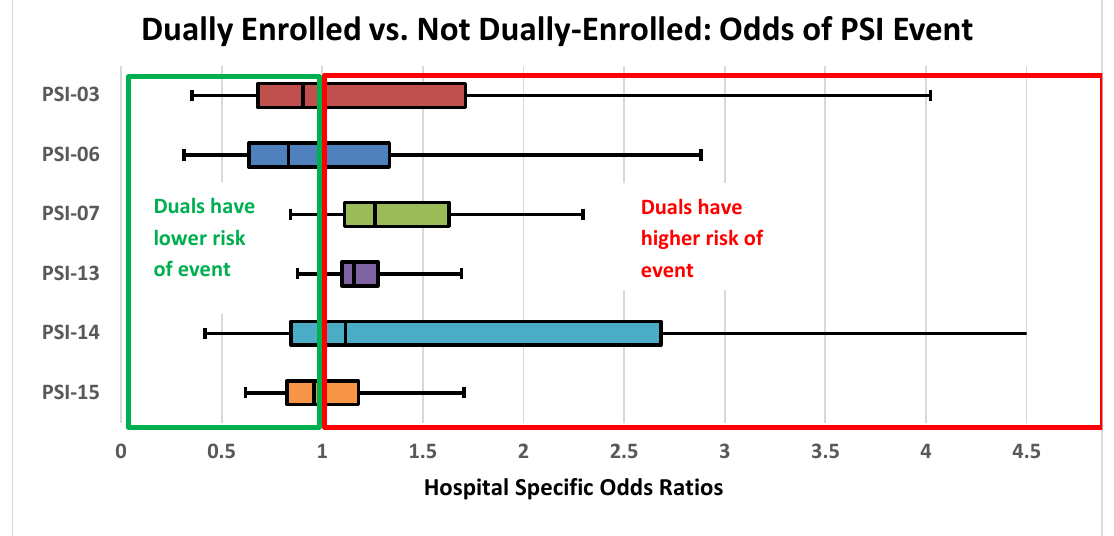
The boxes for each measure represent the odds of a dual having a PSI event at the 5 th and 95 th percentile of all hospitals. The vertical bar is the median odds ratio; the whiskers are the minimum and maximum